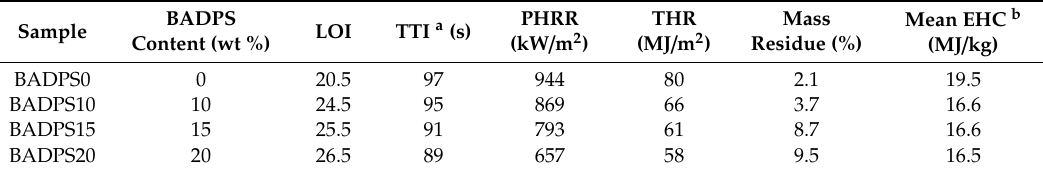
Table 3. Cone calorimetry data for the di ff erent UPRs.